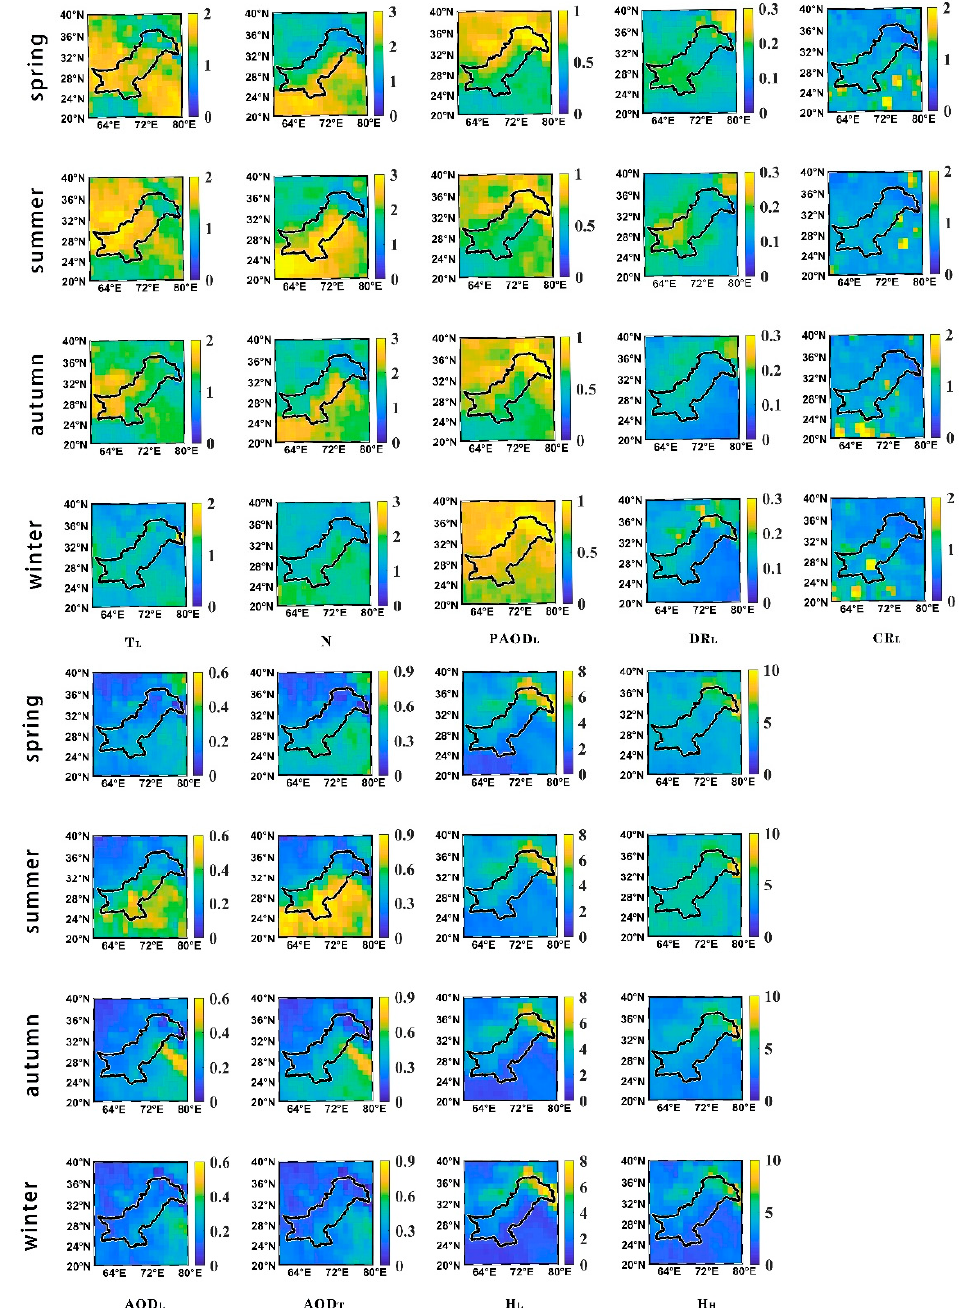
Figure 4. Seasonal spatial distributions of AOD T , AOD L , H L , H H , N, T L , PAOD L , DR L , and CR L over Pakistan during the daytime.